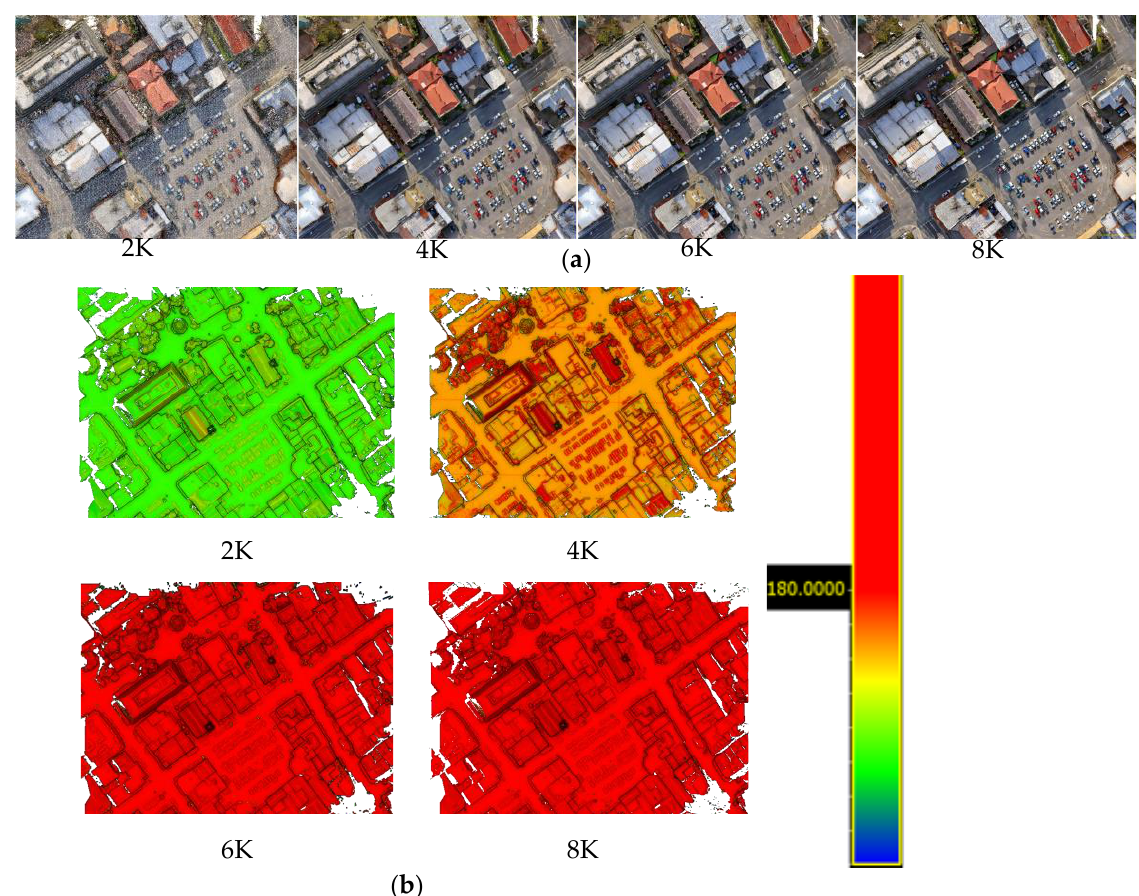
Figure 8. ( a ) The created point clouds using the four video resolutions. ( b ) The achieved point density using the four video resolutions, red-colored when density > 180 pts/m 2 .